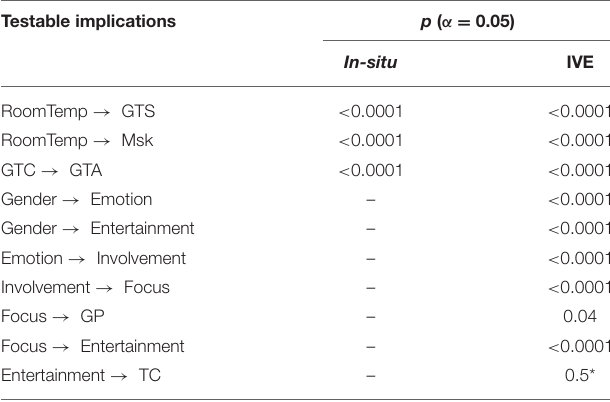
TABLE 6 | Cross-validation results of the hypothesis tests in thermal state analysis. Testable